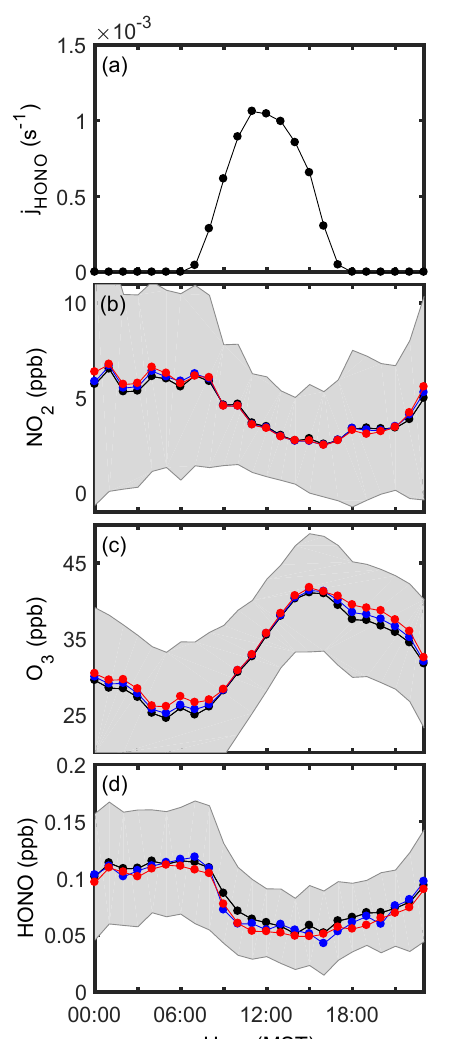
Figure 5. Sunny day hourly averages of the HONO photolysis fre- quency (a) and lower, middle, and upper LP-DOAS light-path mix- ing ratios of (b) NO 2 , (c) O 3 , and (d) HONO during UBWOS 2012. The color coding of the light paths is given in Fig. 1, i.e., lower light path in black, middle light path in blue, and upper light path in red. The gray shading denotes the spread of the observed light-path aver- aged mixing ratios expressed as a 1 σ variability of the hourly data.